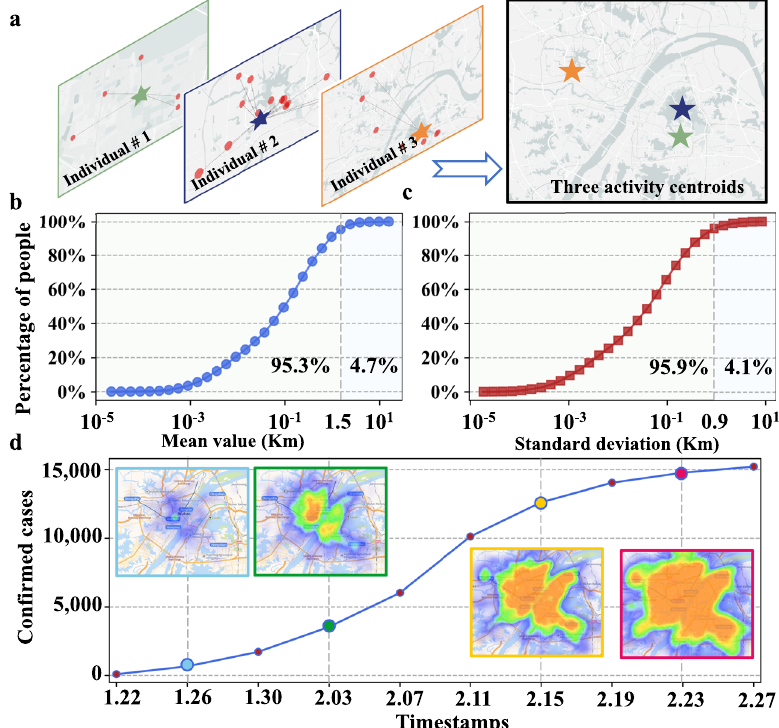
Fig. 4 Activity centroids and visualization of COVID-19 spreading in Wuhan. a An illustration of calculating the activity centroids of smartphone users based on their activity locations. b – c The cumulative distributions of the mean and variance of the distance between activity centroids of each smartphone user in 1 – 6 months and the average centroid. d Visualizing the spatial-temporal spreading of COVID-19 in Wuhan between 22 January 2020 and 27 February